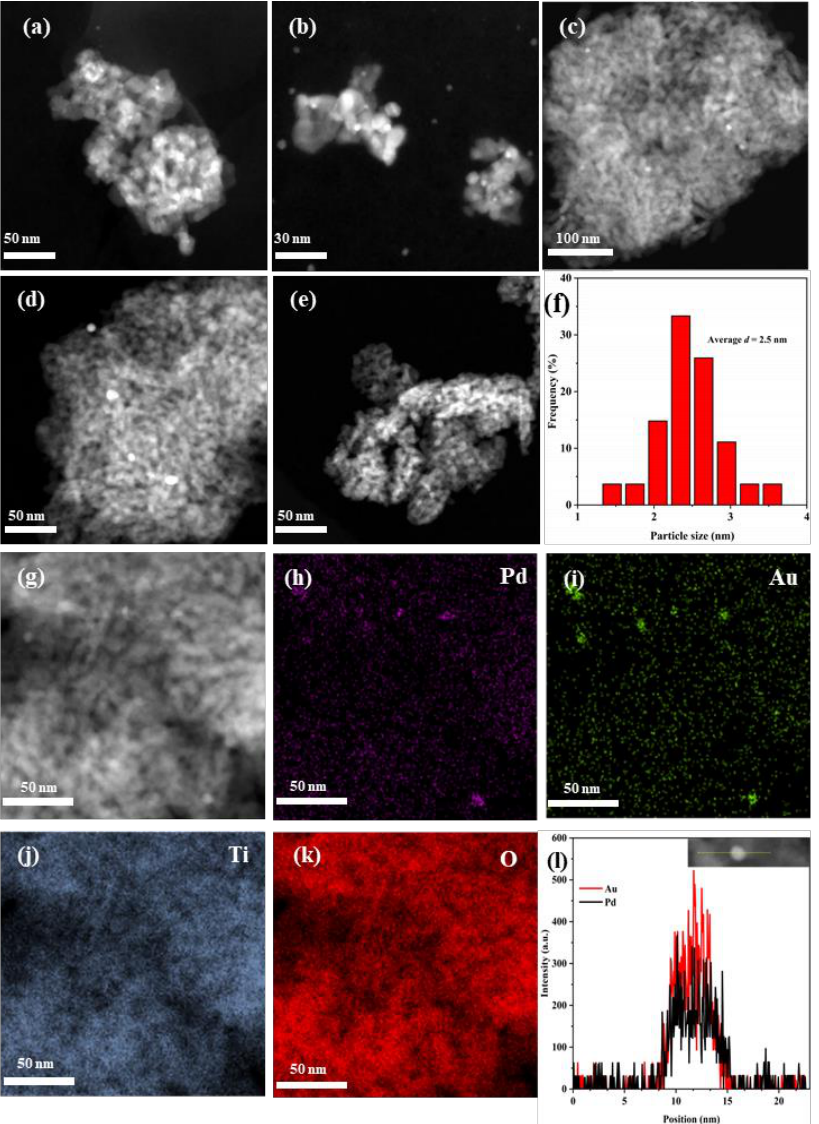
Figure 2. HAADF – STEM images of ( a , g ) 0.37AuPd 2.72 /TiO 2 , ( b ) 0.34AuPd 2.09 /TiO 2 , ( c ) 0.35AuPd 0.46 /TiO 2 , ( d ) 0.36Au/TiO 2 , ( e ) 0.33Pd/TiO 2 , ( f ) particle-size distribution of AuPd 2.72 NPs, ( h – k ) elemental mappings, and ( l ) line scan of 0.37AuPd 2.72 /TiO 2 .